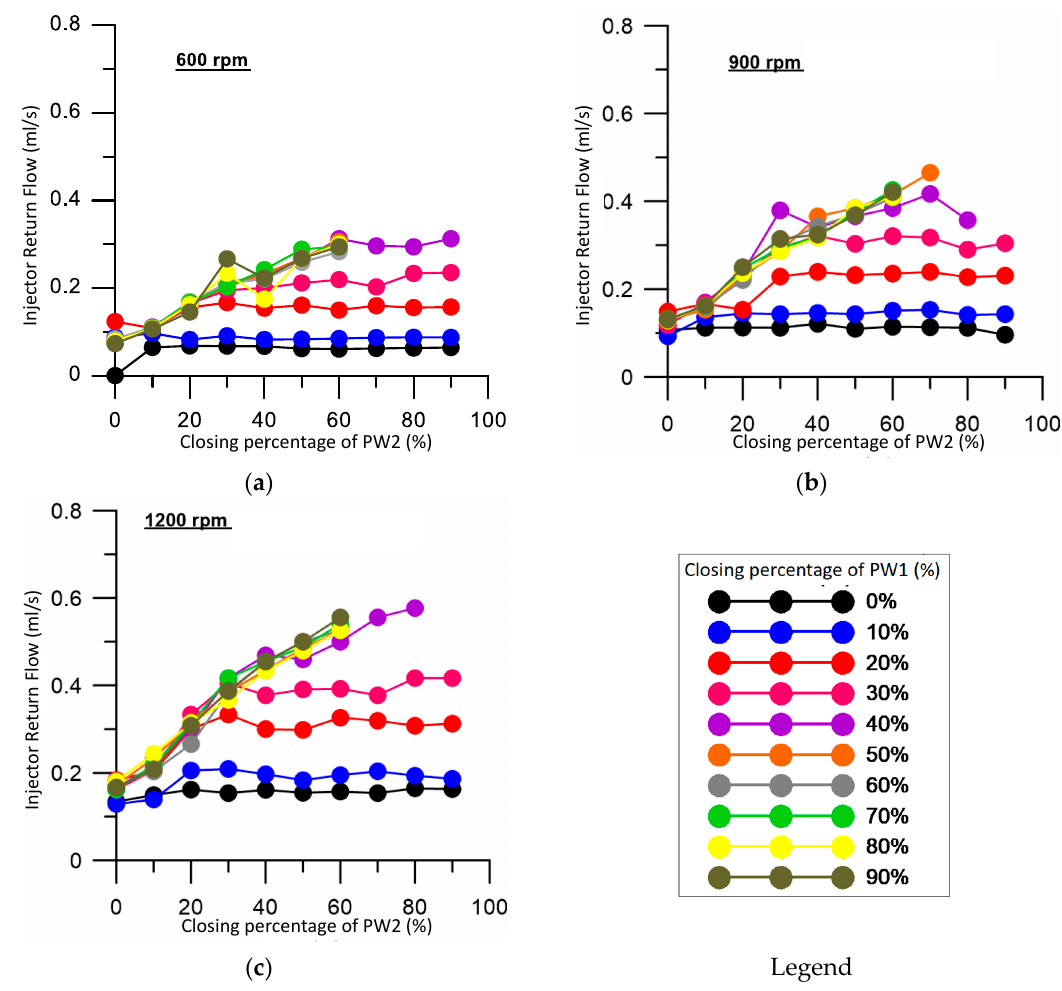
Figure 5. Injector return flow: ( a ) 600 rpm HPP rotational speed; ( b ) 900 rpm HPP rotational speed; and ( c ) 1200 rpm HPP rotational speed.